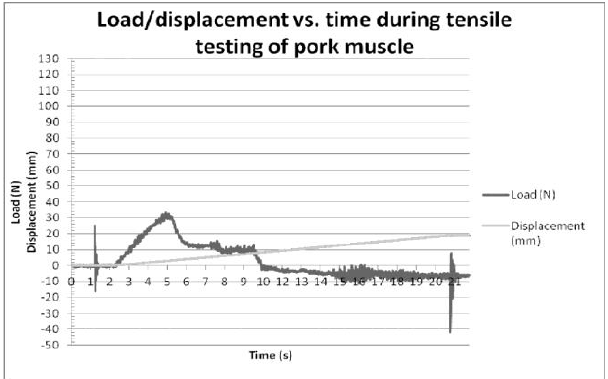
Figure 6. Load/displacement against time of pork intercostal muscle under tensile load resulting in specimen failure at 34 N.